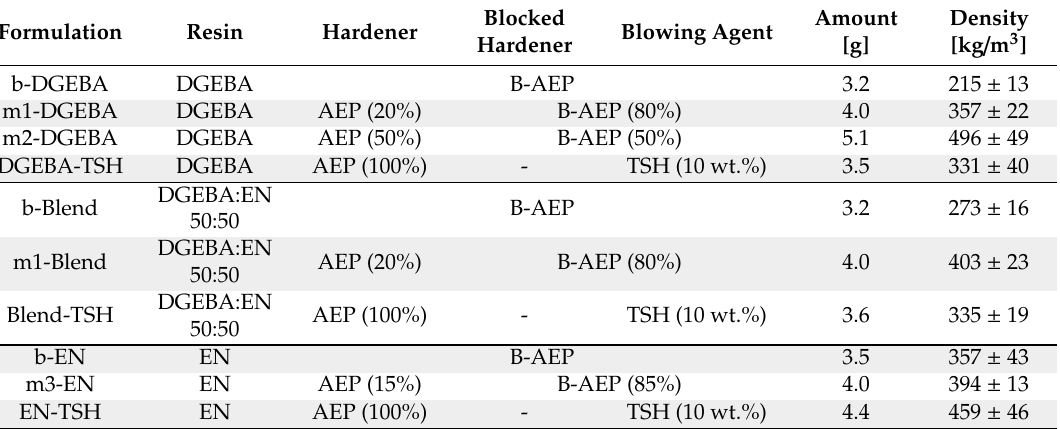
Table 1. Overview of formulations prepared for foaming (% is related to stoichiometric hardener equivalent), the amount of mixture required for proper mold filling of expanded foam, and the final density achieved with respective formulation. AEP: N–aminoethylpiperazine, B-AEP: blocked hardener N-Aminoethylpiperazine, DGEBA: diglycidyl ether of bisphenol-A, EN: epoxy-novolac, TSH: toluenesulfonyl